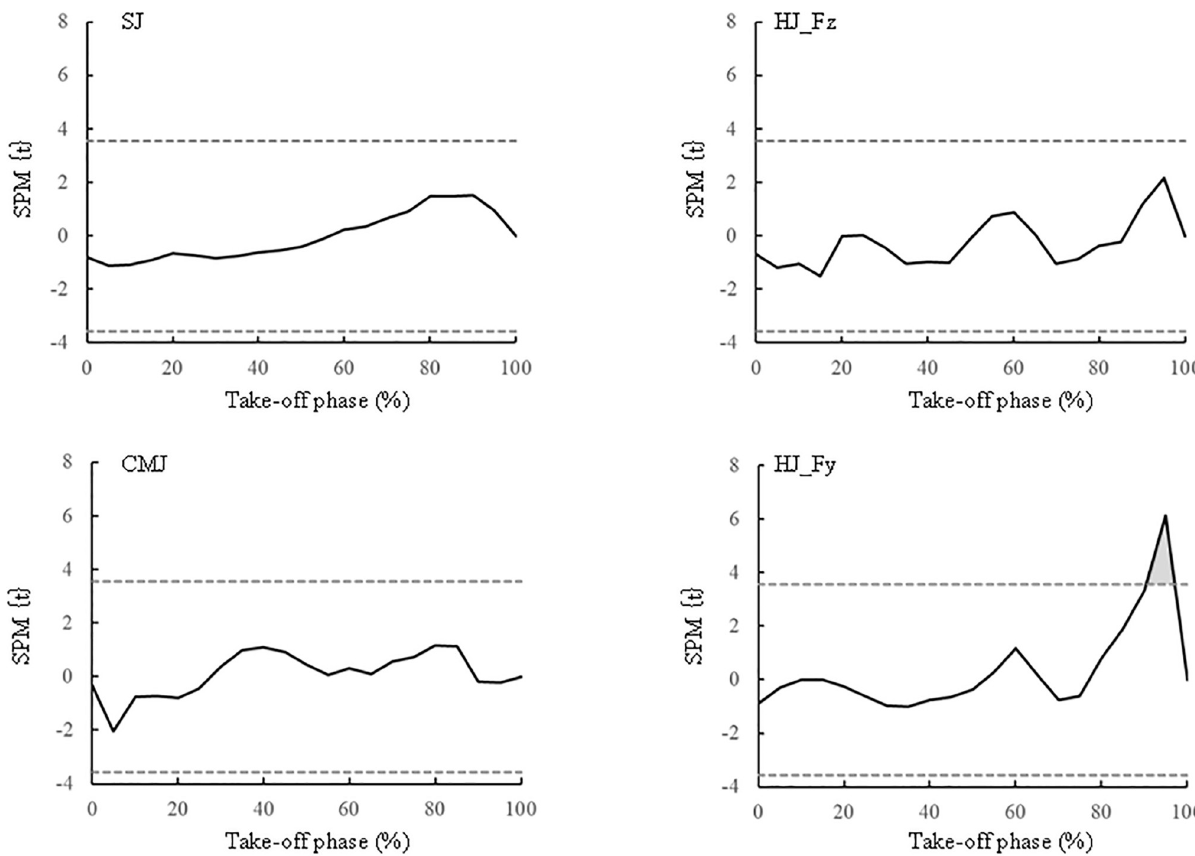
Fig 5. The statistical parametric mapping (SPM) in relative changes in the ground reaction force (GRF) during the take-off phase of the squat jump (SJ), countermovement jump (CMJ) and horizontal jump (HJ). Grey dotted lines are the critical threshold points where are considered significantly different between BARE and FFIM. Grey area is significant difference between BARE and